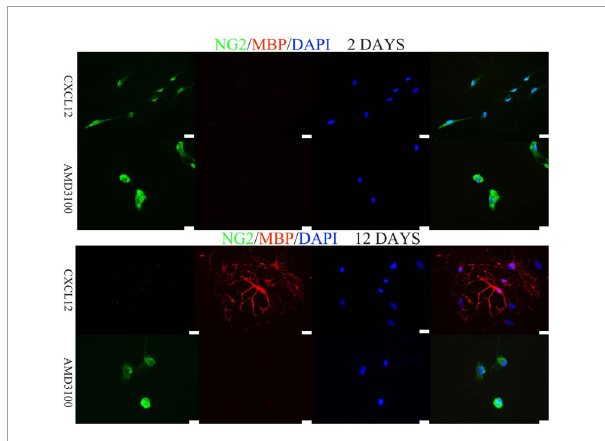
FIGURE6 Differentiation of oligodendrocyte precursor cells (OPCs) into oligodendrocytes in vitro requires the induction of CXCL12. In vitro , 10 ng/ml CXCL12 promoted the differentiation of OPCs. Moreover, 400 ng/ml AMD3100 combined with CXCL12 inhibited differentiation. The bar in the lower right represents 50 µ m.